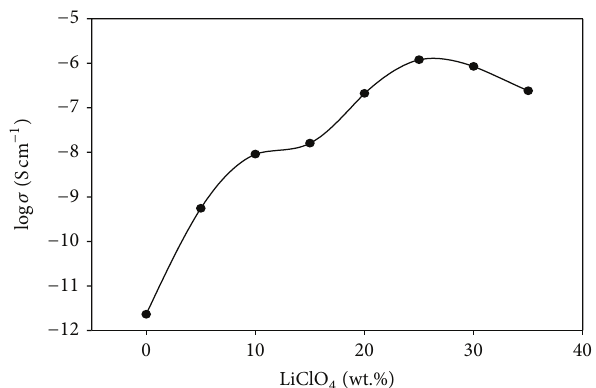
Figure 2: Ionic conductivity of P(GMA-co-MMA)-LiClO 4 based polymer electrolyte as a function of LiClO 4 content.